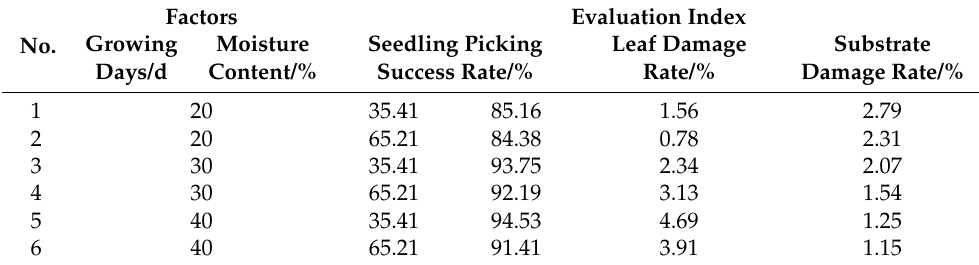
Table 4. Results of the picking test.